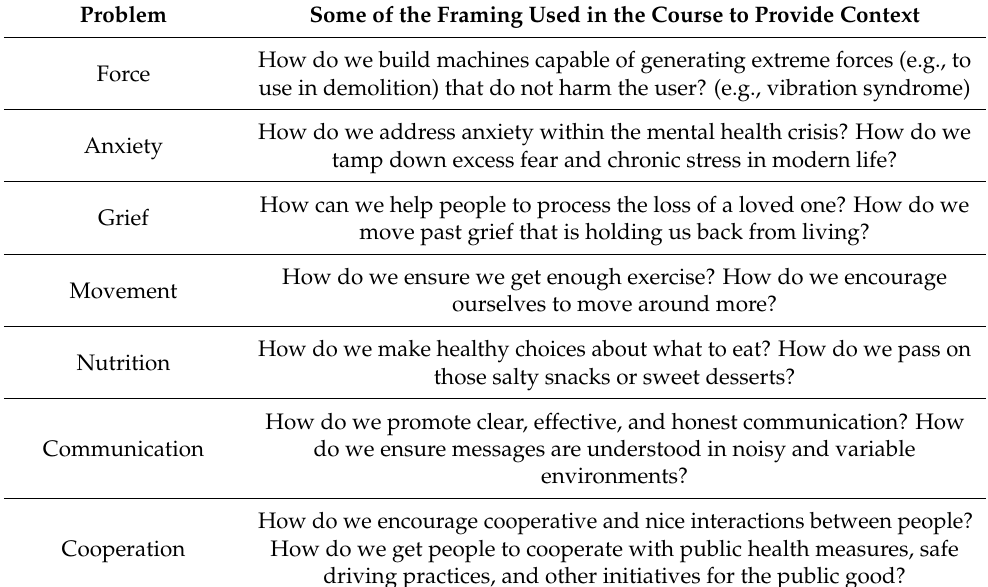
Table 1. Focal problems. Background on how focal problem areas were discussed in class as context for the brainstorming